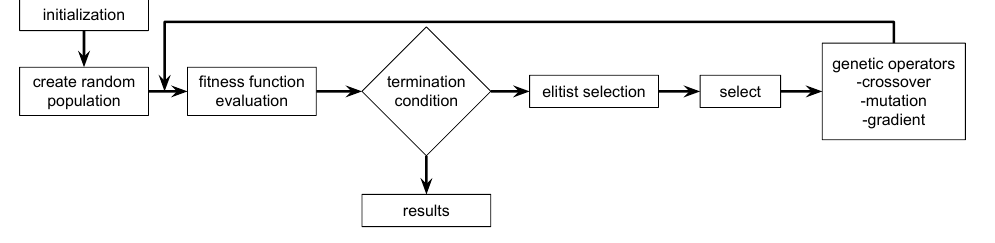
Figure 4. Optimization